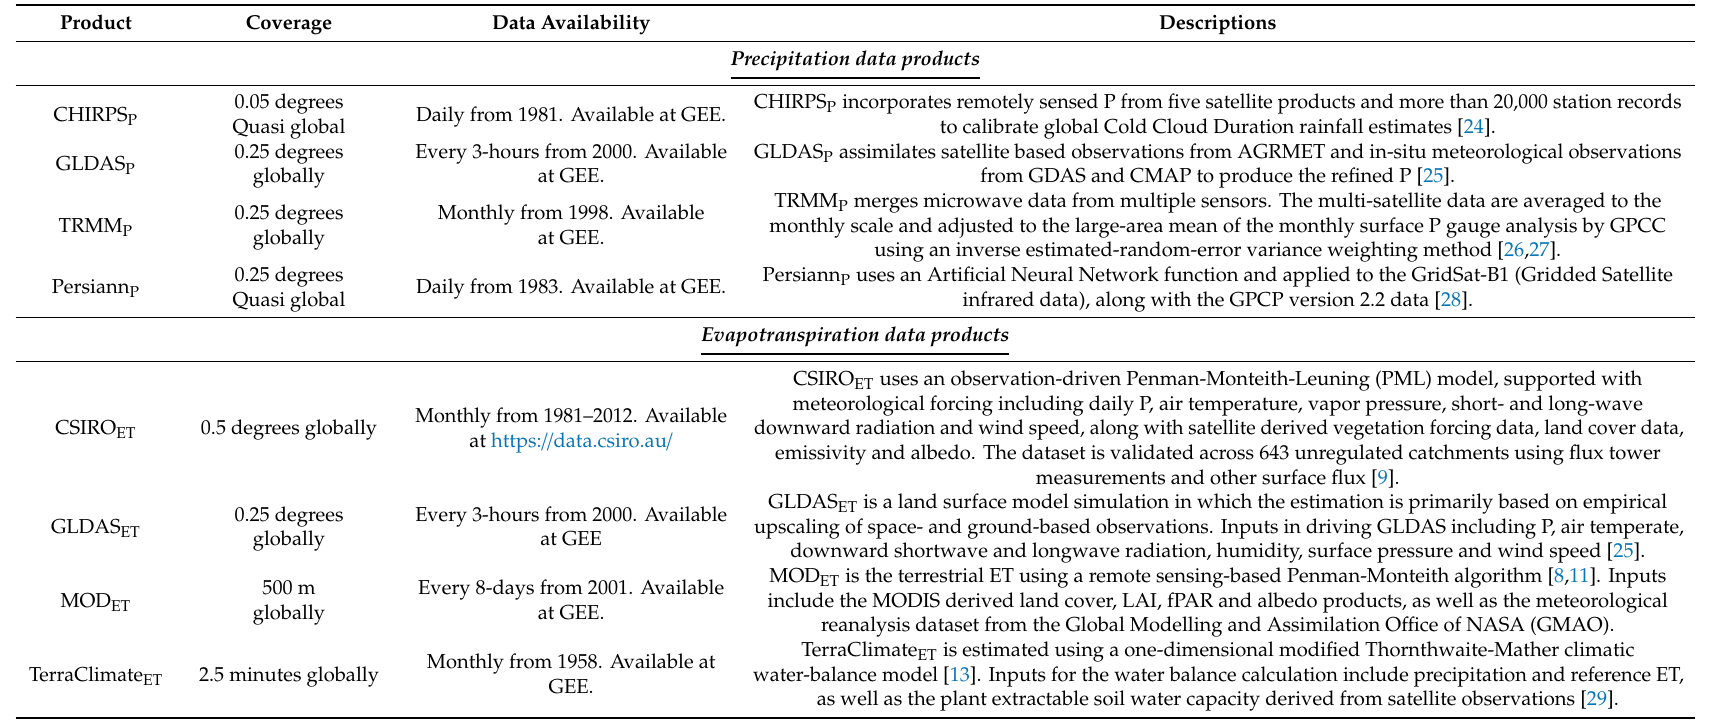
Table 2. Details of the collected global precipitation and evapotranspiration data products. One degree is equivalent to about 110